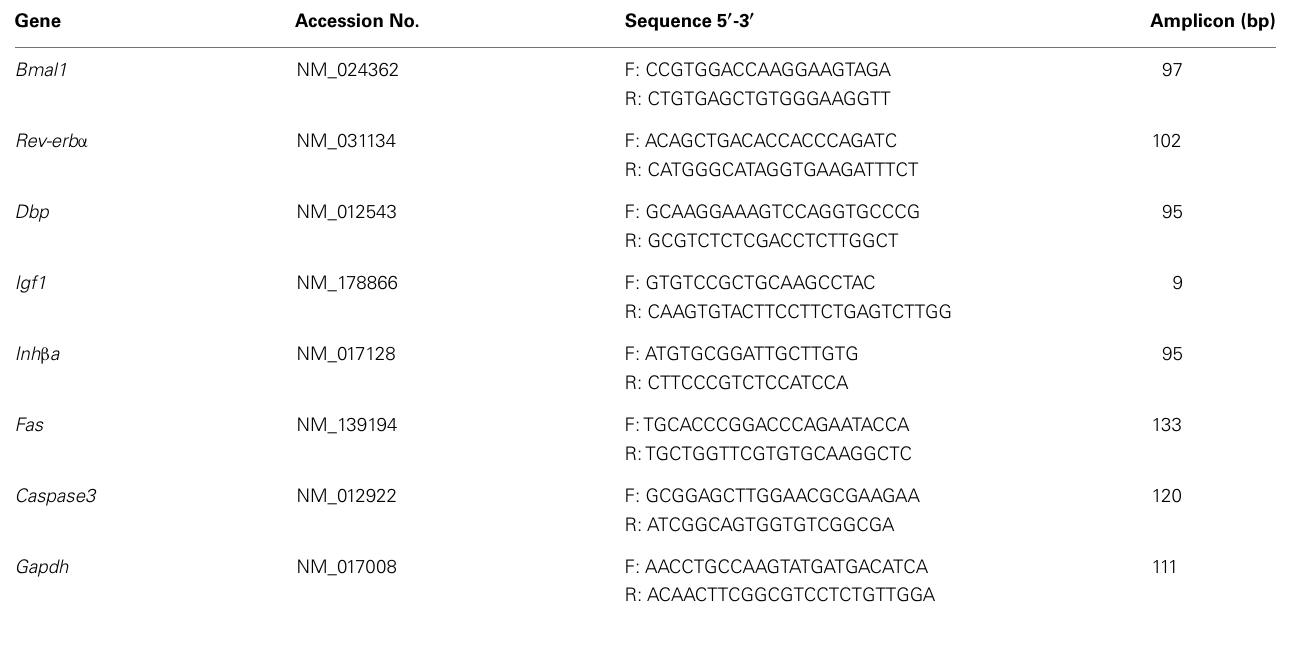
Table 2 | Primer sequences for the targeted genes in qRT-PCR. Gene Accession